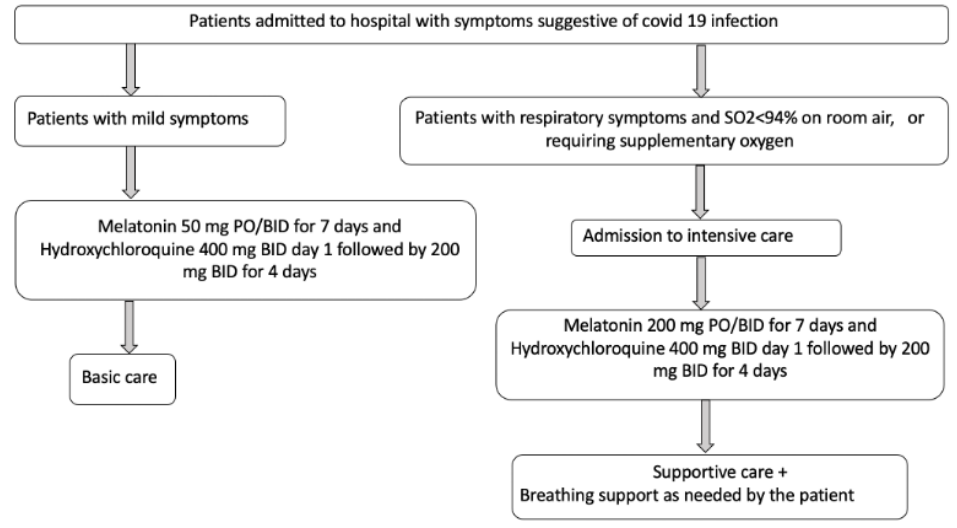
Figure 5. Melatonin administration algorithm against COVID-19. Inspired in Reiter RJ et al. [57].